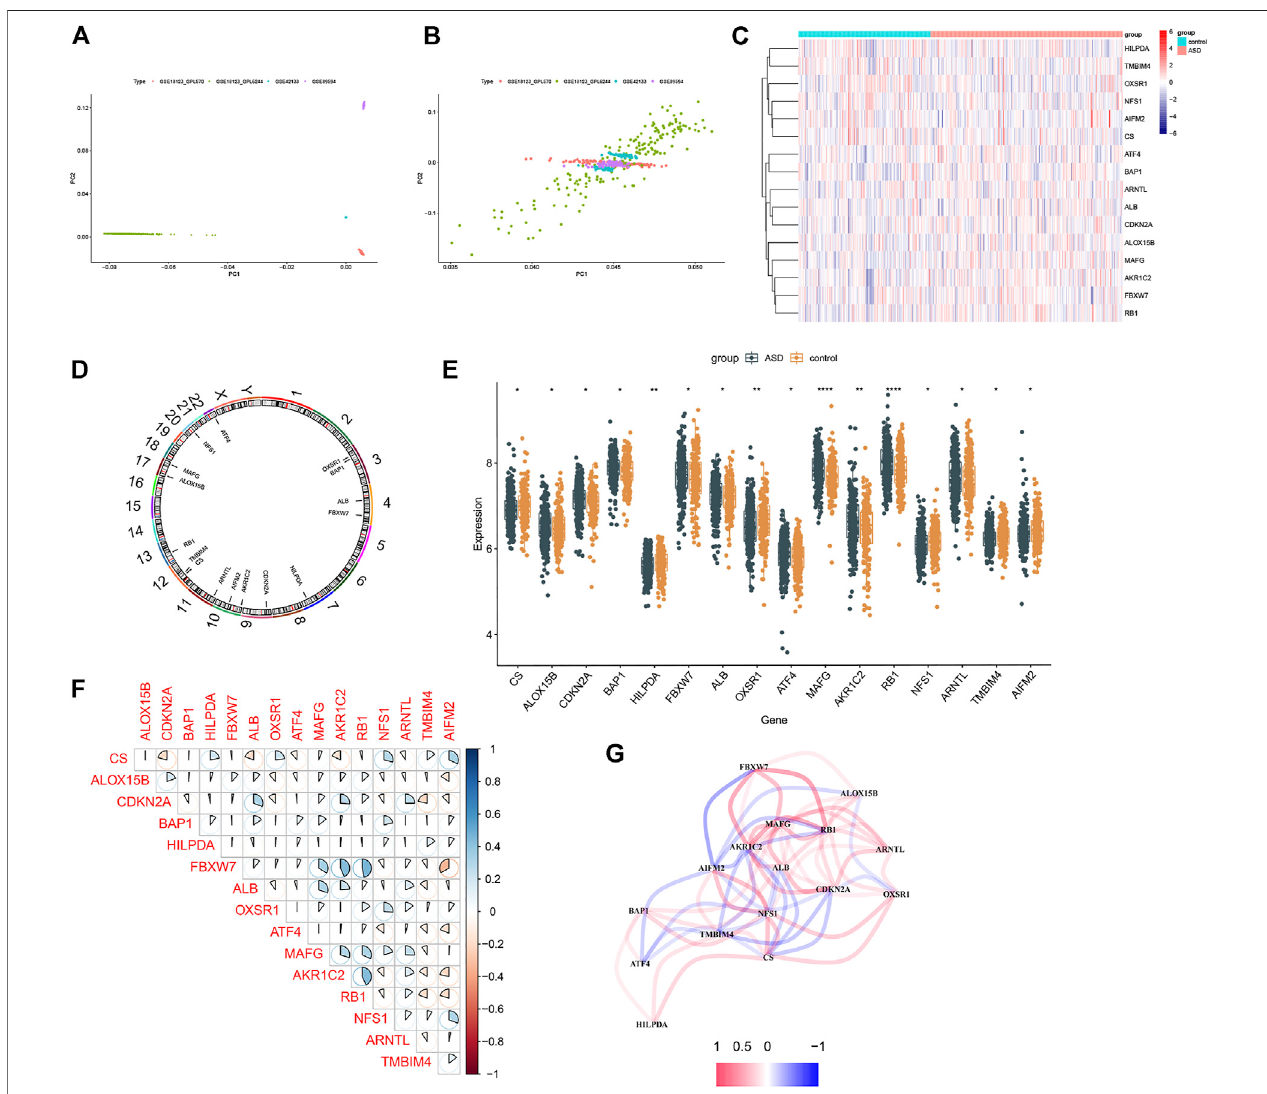
FIGURE 2 | Differential FRGs screening in ASD children. (A and B) Principal component analysis of different datasets before (A) and after (B) batch correction. (C) Representative heatmap of 16 differentially expressed FRGs. (D) The location of 16 differentially expressed ferroptosis genes on chromosomes. (E) Box plots showing the expression of 16 differentially expressed ferroptosis genes in ASD samples and healthy controls. (F) Representative correlation plot of 16 differentially expressed FRGs.Bluerepresentspositivecorrelation,andredrepresentspositivecorrelation.Theareaofthepiechartrepresentsthespeci fi cvalueofcorrelationcoef fi cients. (G) Representative gene relationship network diagram of 16 differentially expressed